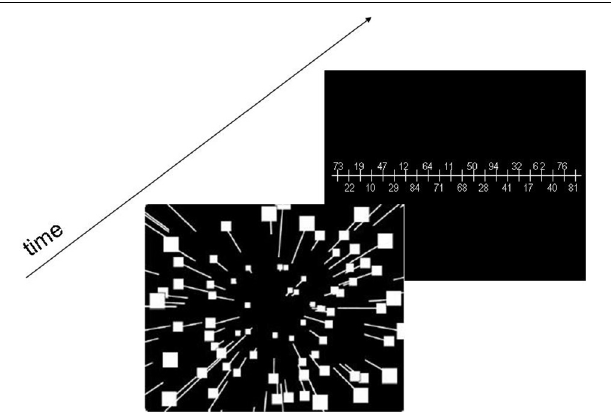
FIGURE 1 | Schematic Diagram of the stimulus design. The presentation time of the optic flow stimulus varied between 200 and 2000ms. After stimulus presentation a ruler with pseudo-randomized numbers was presented in the visual field and subjects were asked to indicate their perceived self-motion direction by giving the number on this ruler being closest to this perceived